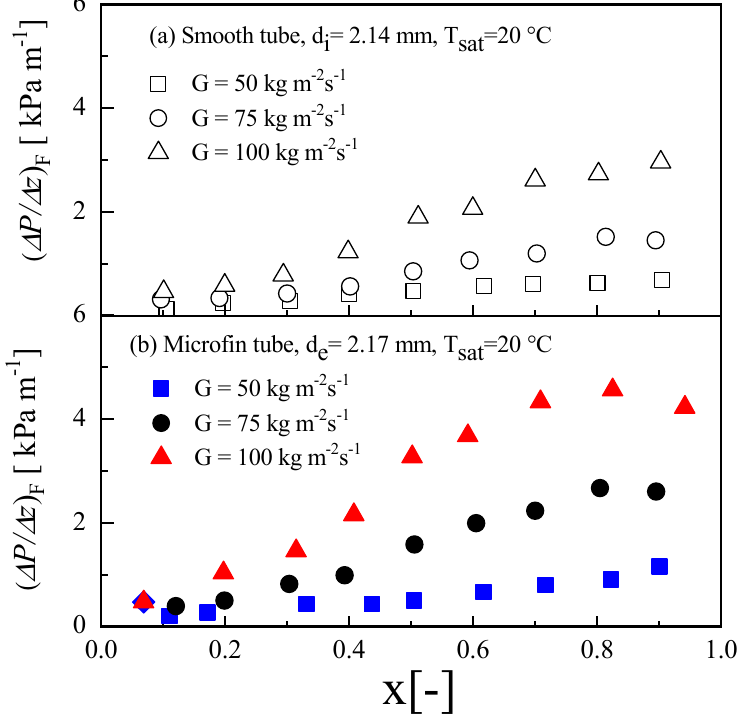
Figure 5. Effects of mass flux and vapor quality on frictional pressure drop: ( a ) smooth tube; and ( b ) microfin tube.